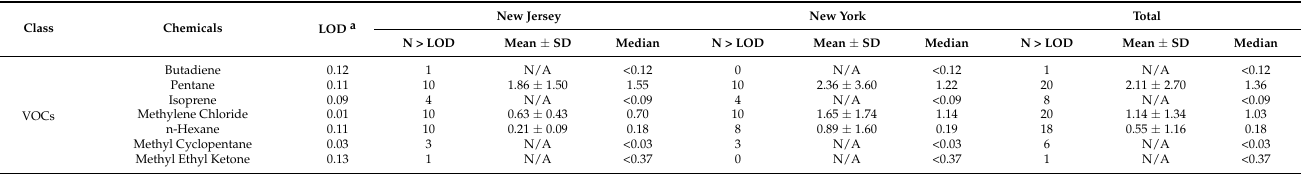
Table 2. Summary of descriptive statistics for 31 VOCs and 7 phthalates measured at 20 nail salons in NJ and NY from February to May